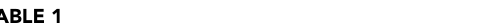
NAHS Suggested Minimum Standards of Indigenous Content about which Participants Felt Most and Least Informed NAHS indigenous content